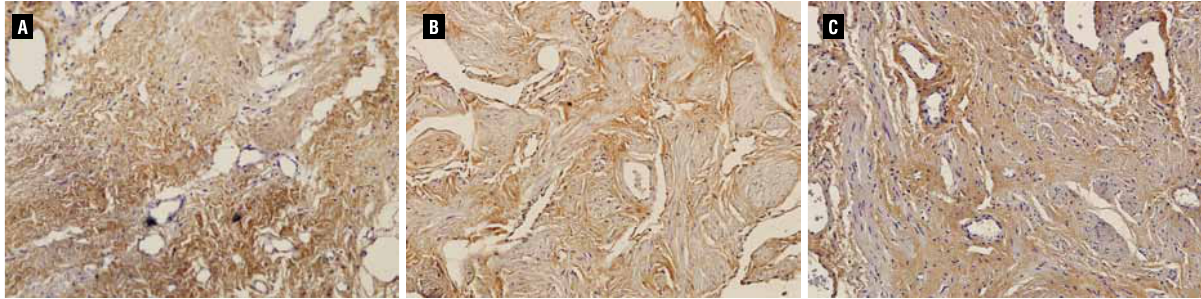
Figure 3 - Imunohistochemical staining for Type III collagen from Control group (A), Proximal edge of stenotic group (B) and distal edge of stenotic group (C), showing a similar distribution in all groups (Immunolabelling,